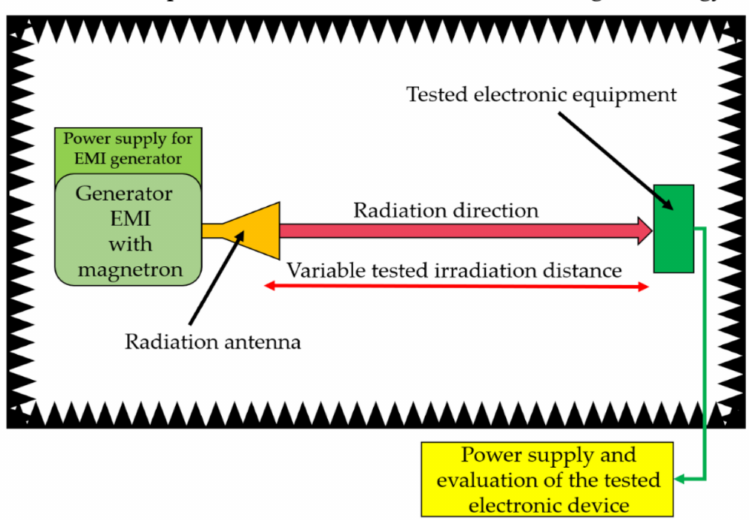
Figure 11. Test site for testing electronic devices in an electromagnetic field.